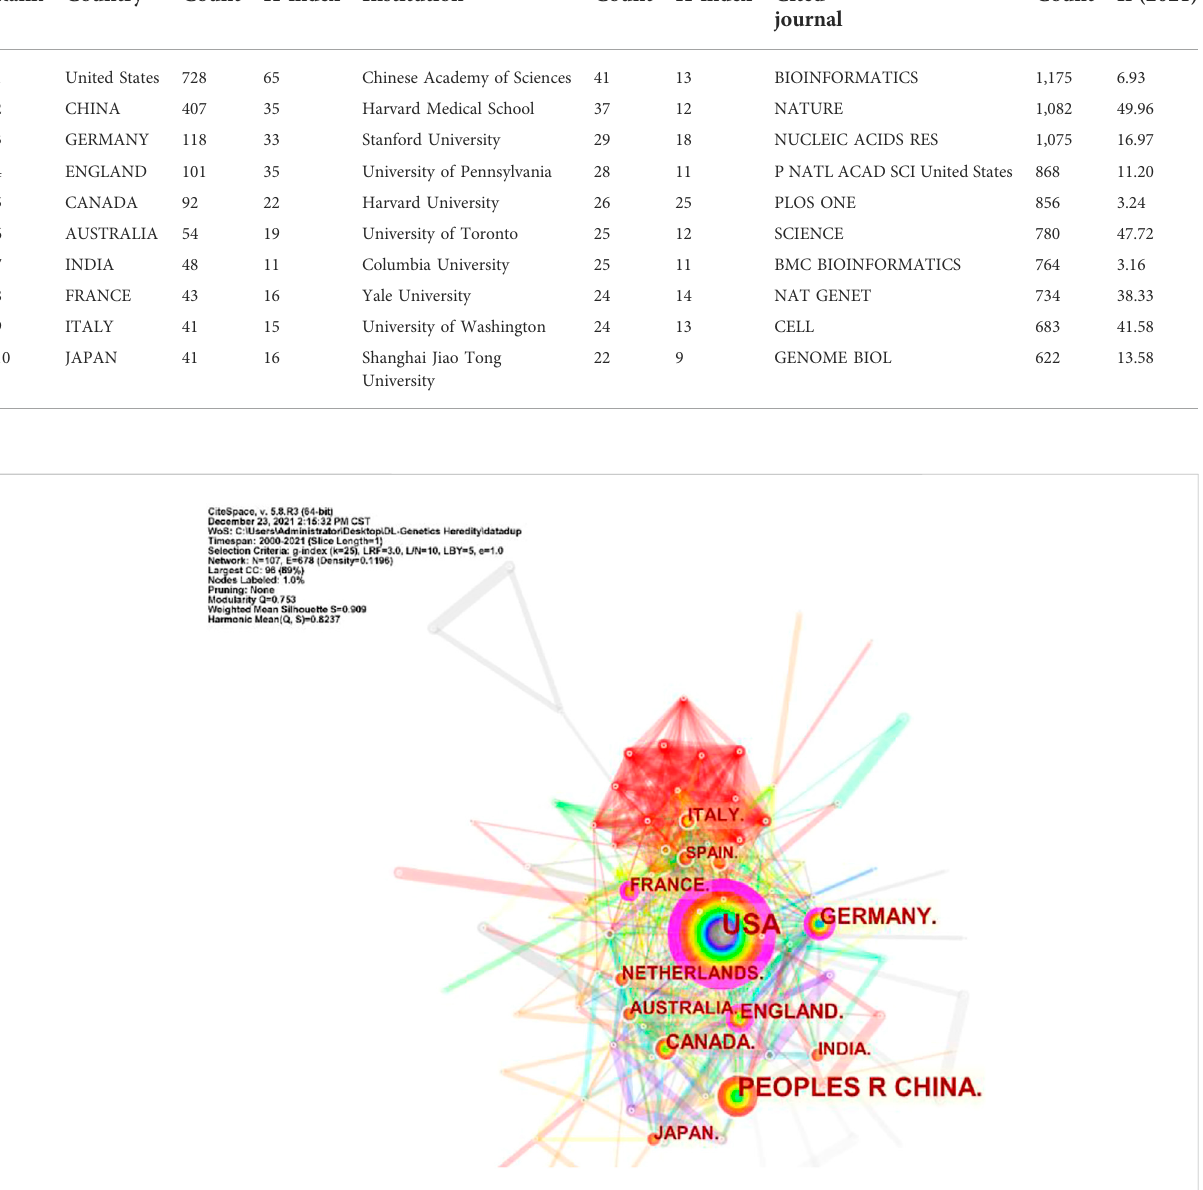
FIGURE 2 Cooperation of countries in the fi eld of Deep Learning application in genetics research from 2000 to